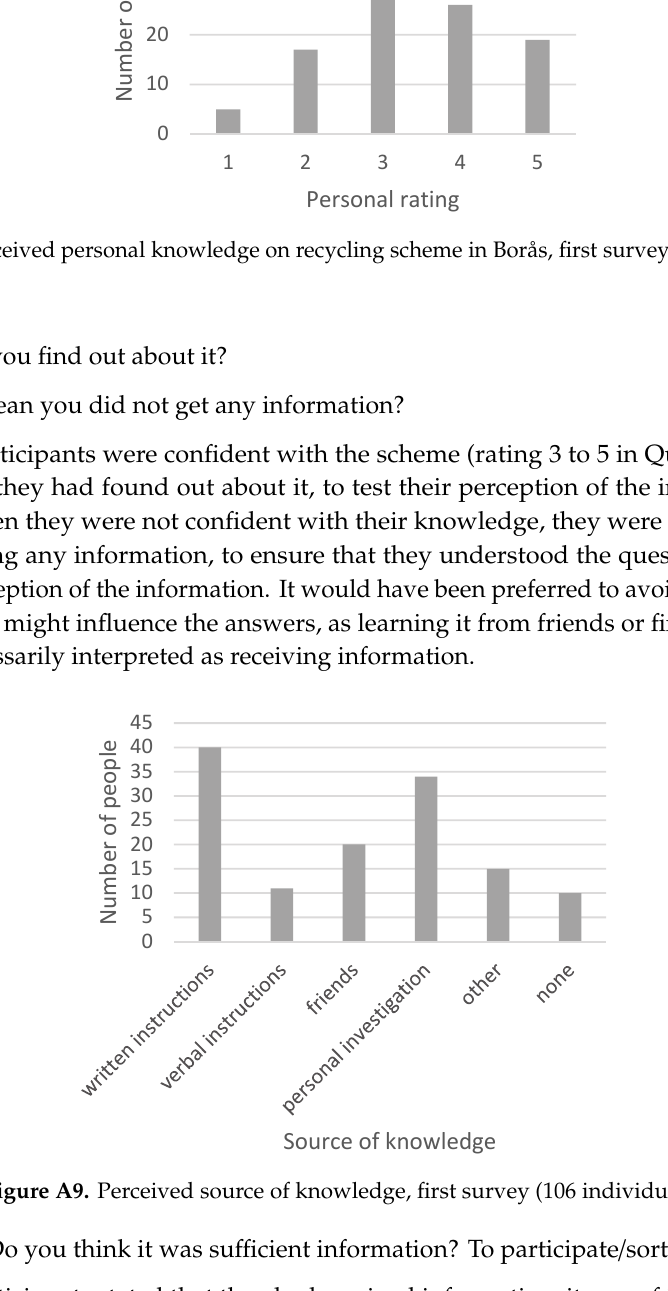
Figure A10 . Rating of usefulness of the current information on the recycling scheme, first survey (49 individuals). Question 10. Where would you put the following waste objects? Different examples (using pictures) for waste were given, and the participants were asked how they would treat them. This indicates their actual behavior as opposed to the perceived one. The examples were a piece of food waste, a shampoo bottle (hard plastic) and plastic wrapping (soft plastic).